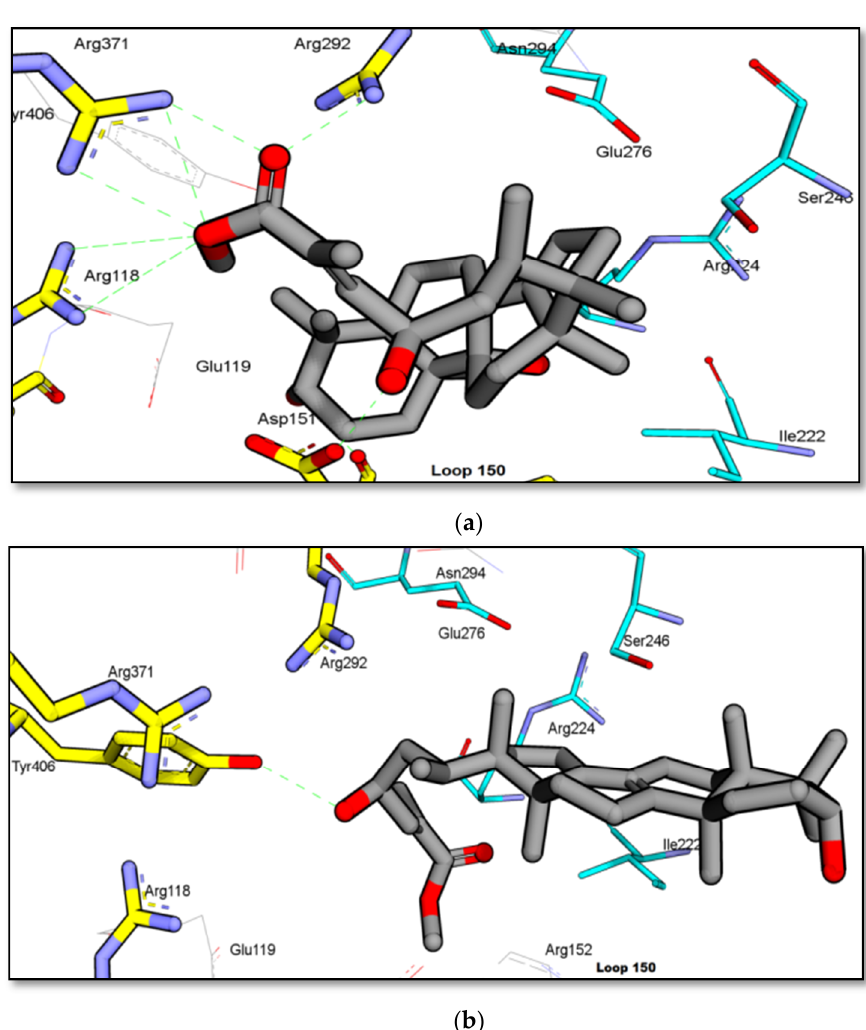
Figure 6. Binding interaction of isolated compounds ( a ) GC2 and ( b ) GC3 from GCL against H 1 N 1 –NA (PDB code: 3B7E). (blue carbon: hydrophobic residues).